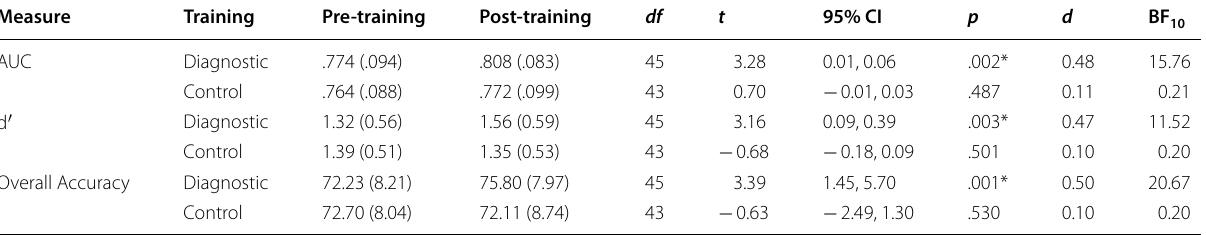
Table 1 Planned paired samples t -tests (AUC) and simple main effects analysis (d ′ , overall accuracy) comparing mean performance pre-training to post-training for both training conditions